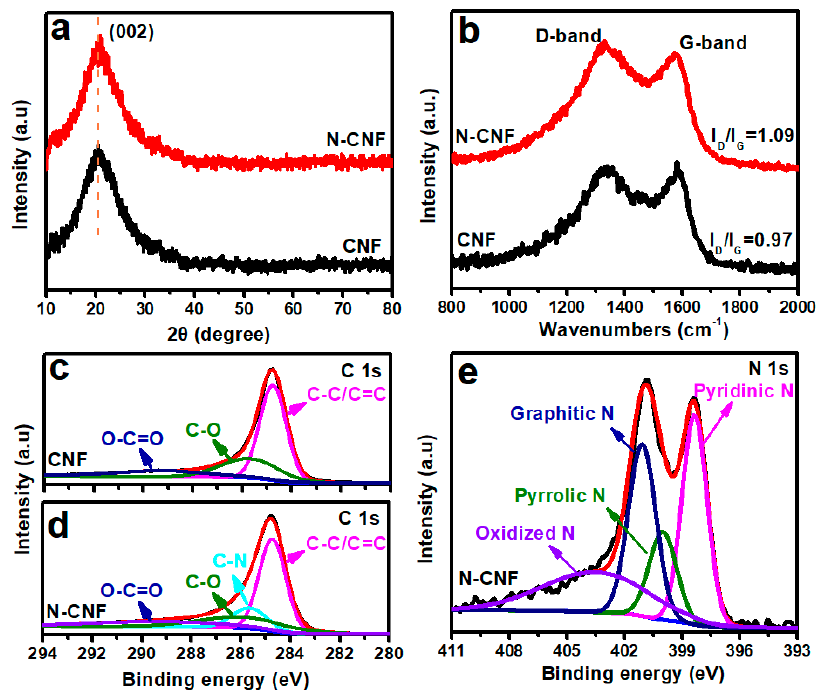
Figure 2. ( a ) XRD patterns and ( b ) Raman spectra of CNF and N-CNF; C 1 s XPS spectra of ( c ) CNF and ( d ) N-CNF, ( e ) N 1 s XPS spectrum of N-CNF.